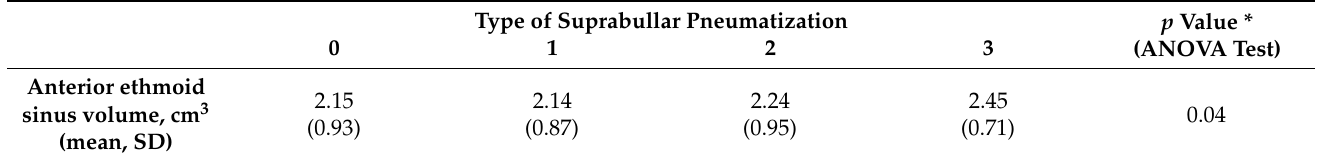
Table 3. The association between anterior ethmoid sinus volume and type of suprabullar